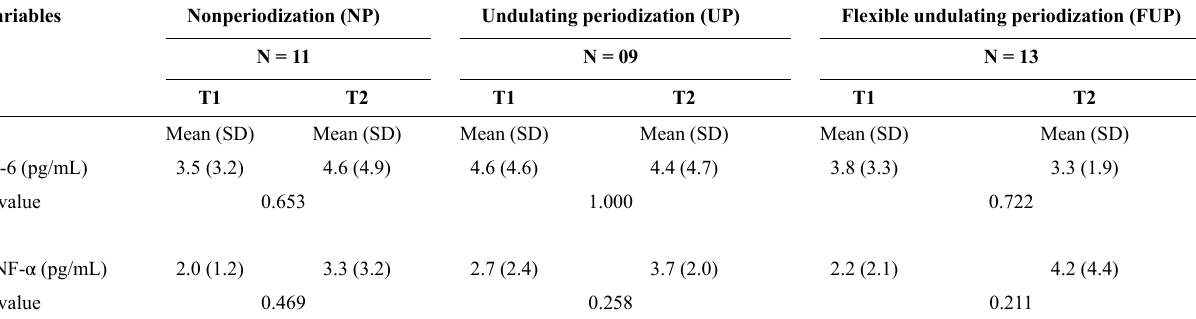
Table 3 - Distribution of the participants regarding IL-6 and TNF- α levels, by physical training group and evaluation time. Variables